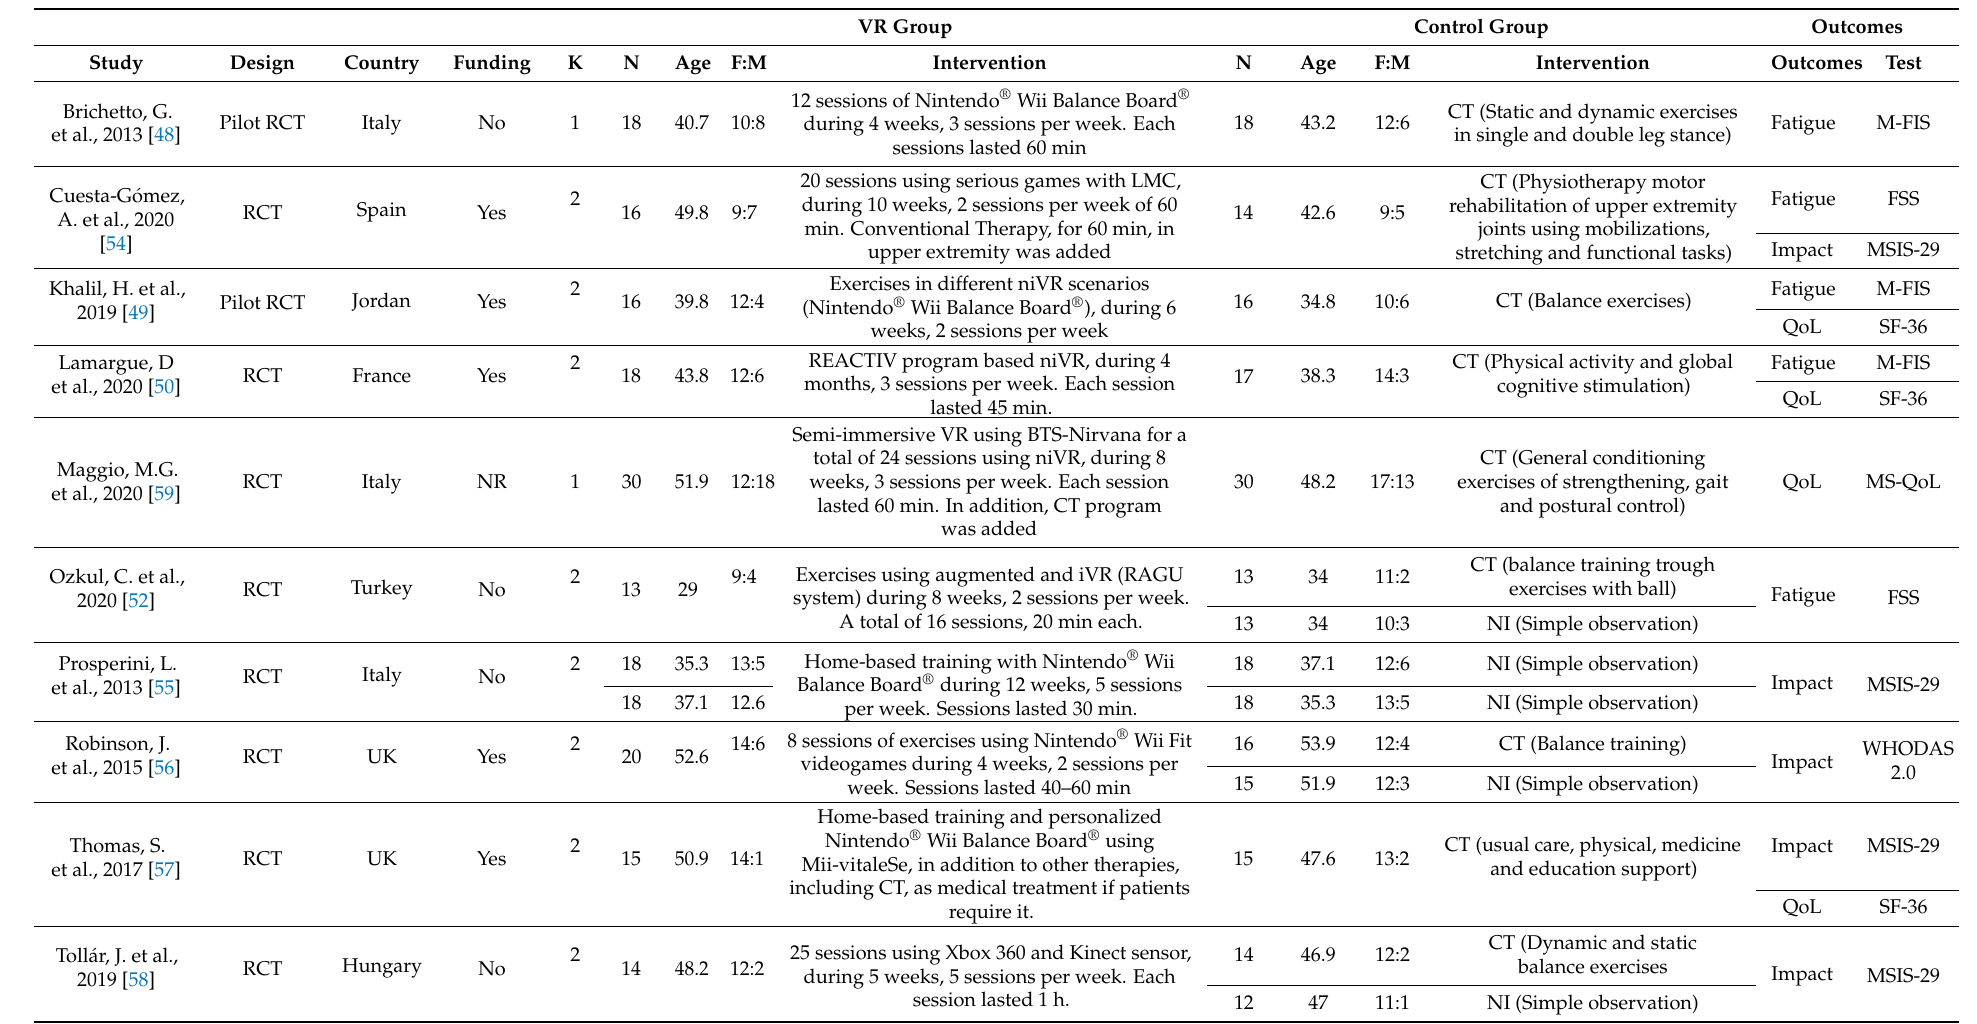
Table 2. Characteristics of the Studies Included in the Review. VR Group Control Group